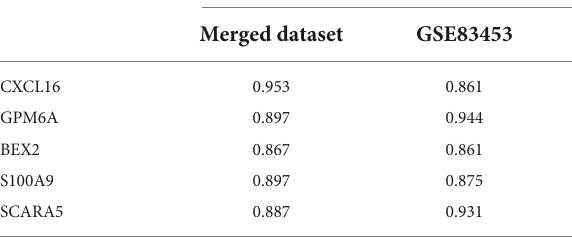
Genes Diagnostic efficacy (Area under